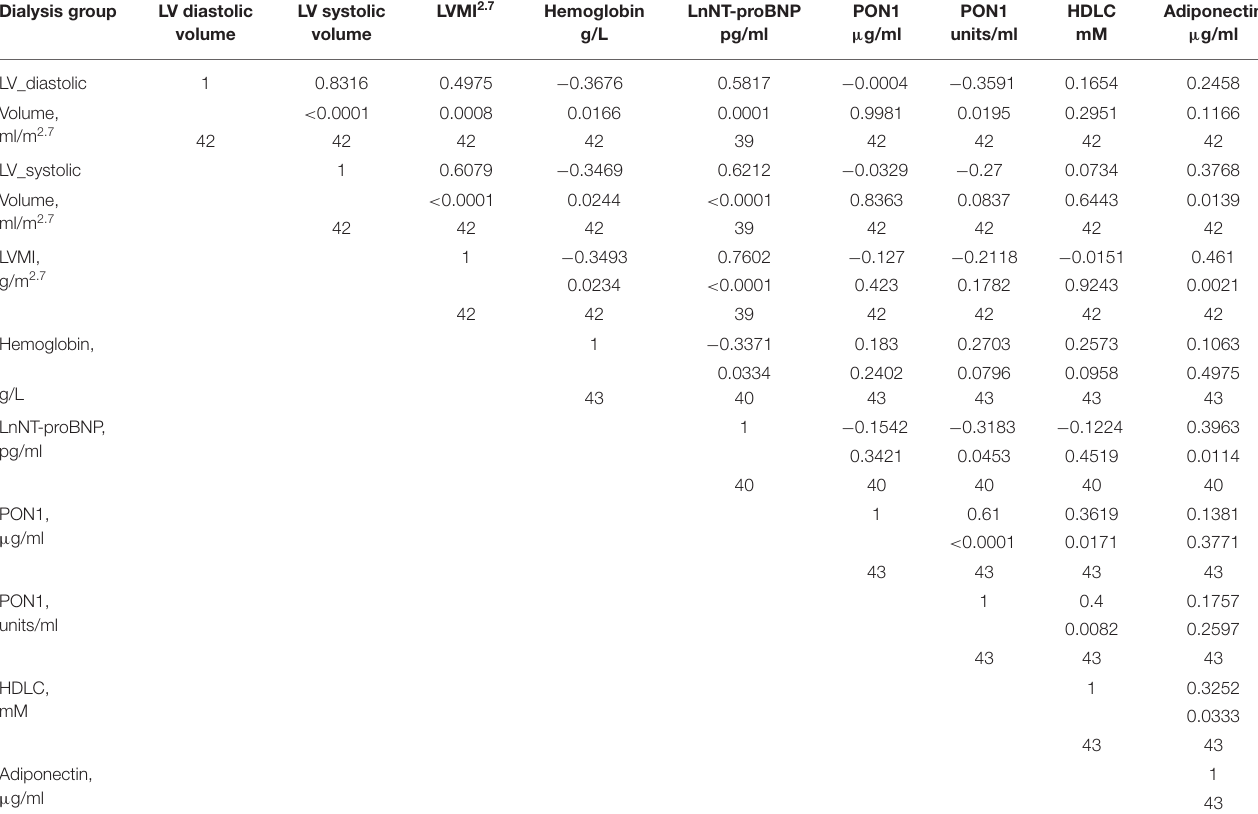
TABLE 5 | Pearson correlation of change in left ventricular measurements and hemoglobin with PON1, HDL cholesterol, and adiponectin for subjects on dialysis. Dialysis group